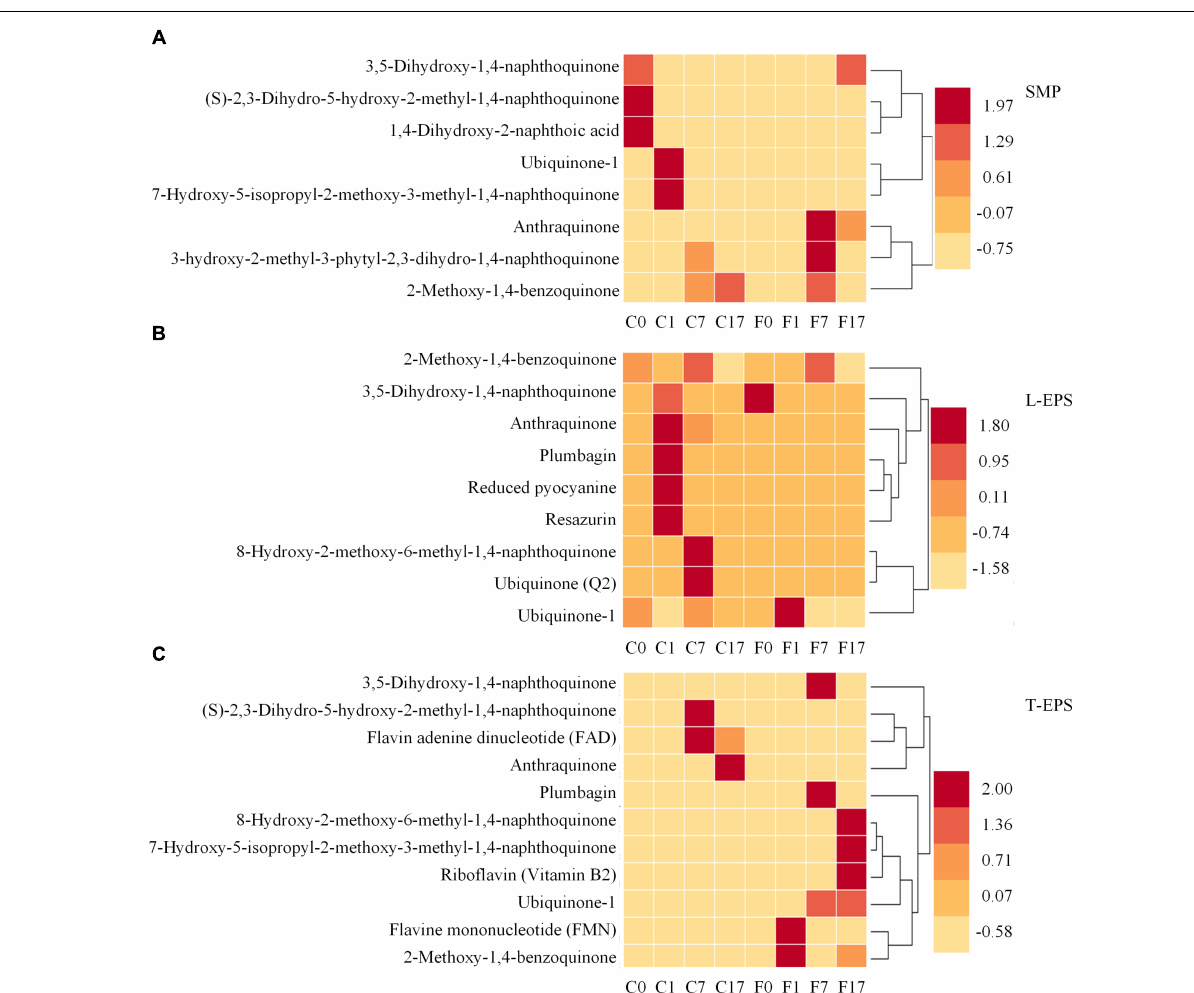
FIGURE 6 | Distribution of quinone substances and other potential electron shuttles in (A) SMP phase, (B) L-EPS phase, and (C) T-EPS phase at different steps in the control and Fe 3 O 4 reactors. C0, C1, C7, and C17 refer to samples collected from the control reactor at 0, 1, 7, and 17 h. F0, F1, F7, and F17 refer to samples collected from the Fe 3 O 4 reactor at 0, 1, 7, and 17